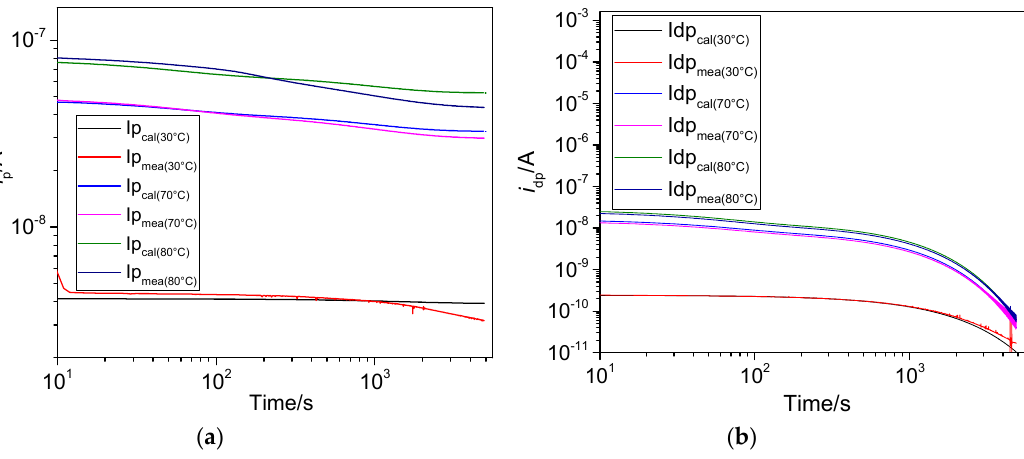
Figure 8. ( a ) Polarization current; ( b ) depolarization currents modelled from the parameterized EDM using FDS measurements.